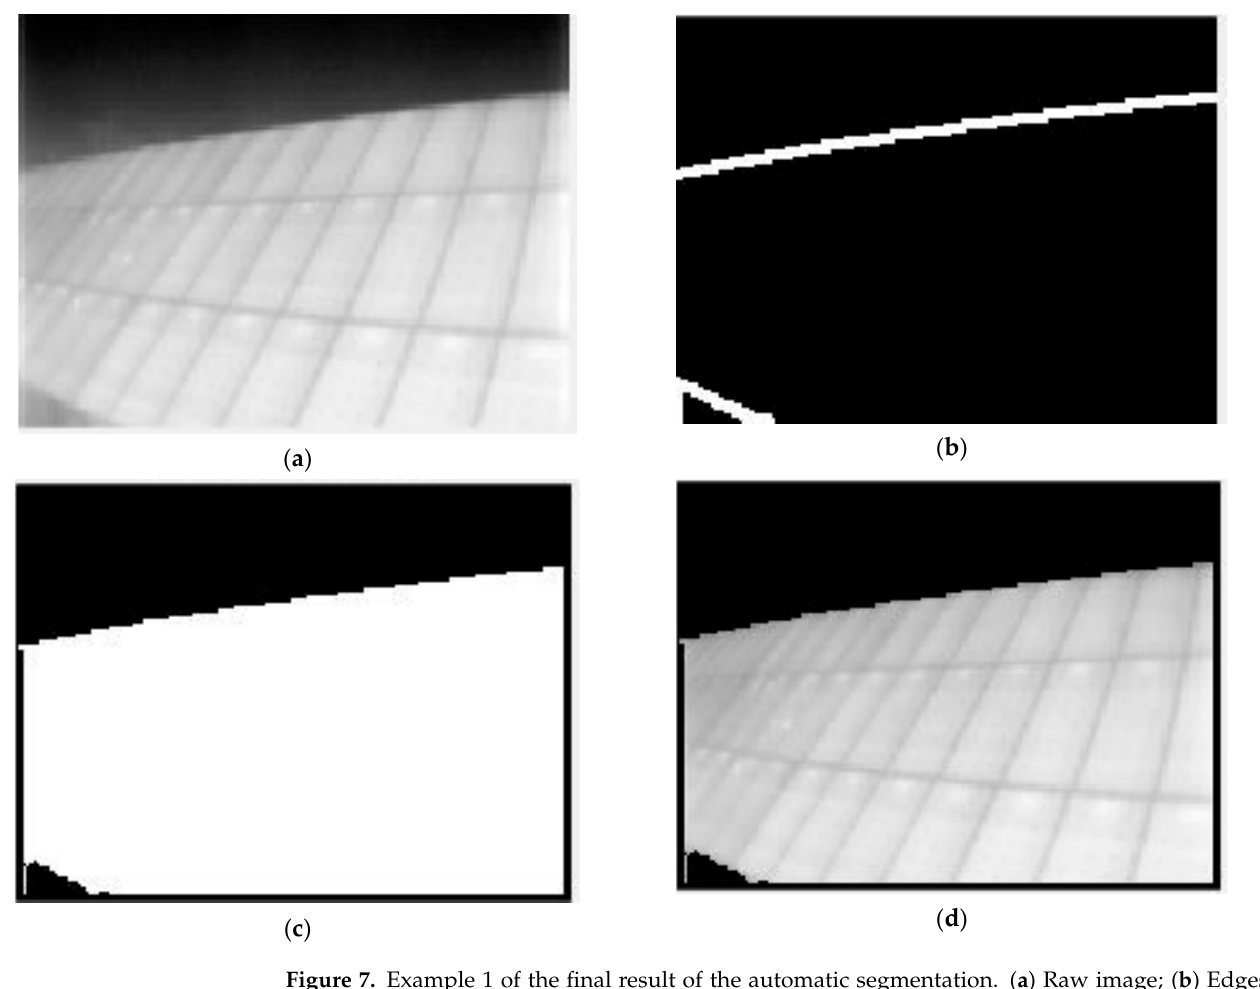
Figure 7. Example 1 of the final result of the automatic segmentation. ( a ) Raw image; ( b ) Edges thicked; ( c ) Area of interest; and ( d ) segmented image.